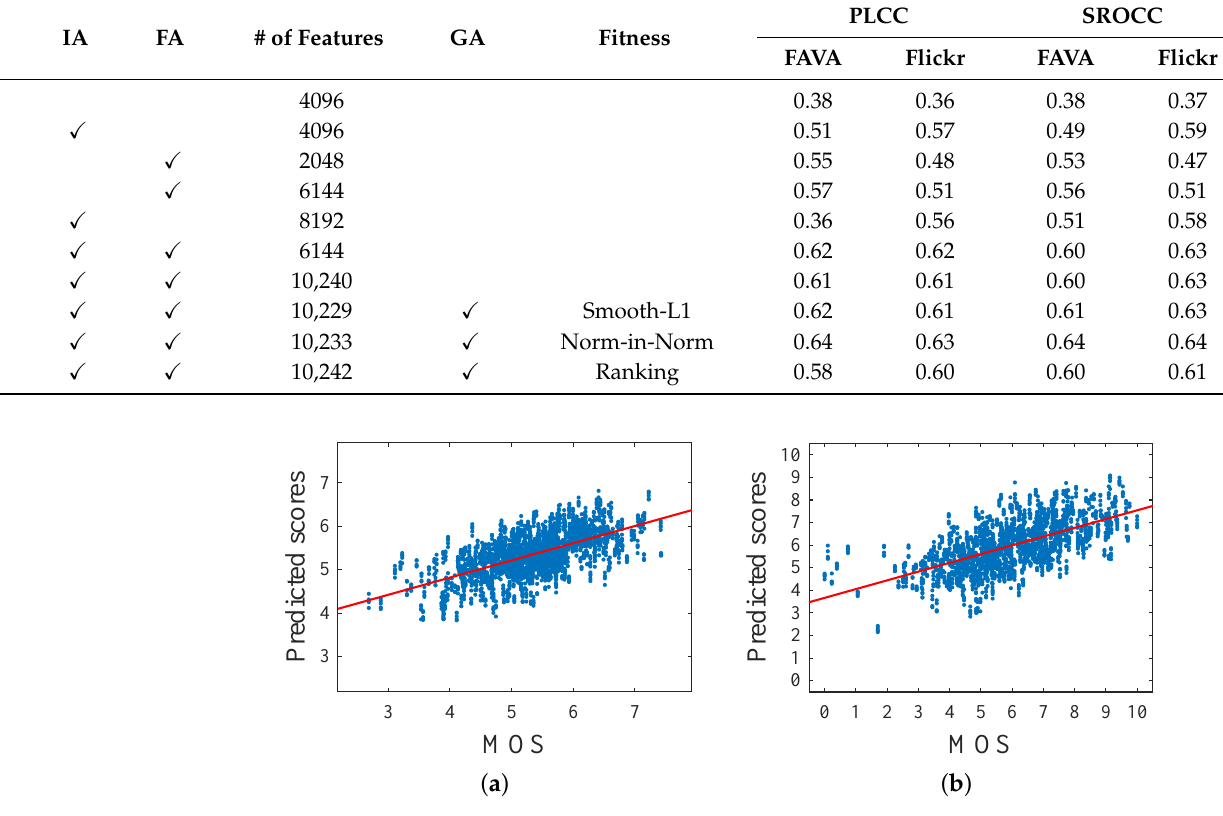
Figure 13. Scatter plots of predicted scores versus MOS for the databases ( a ) FAVA and ( b ) Flickr, using perceptual features extracted from the whole